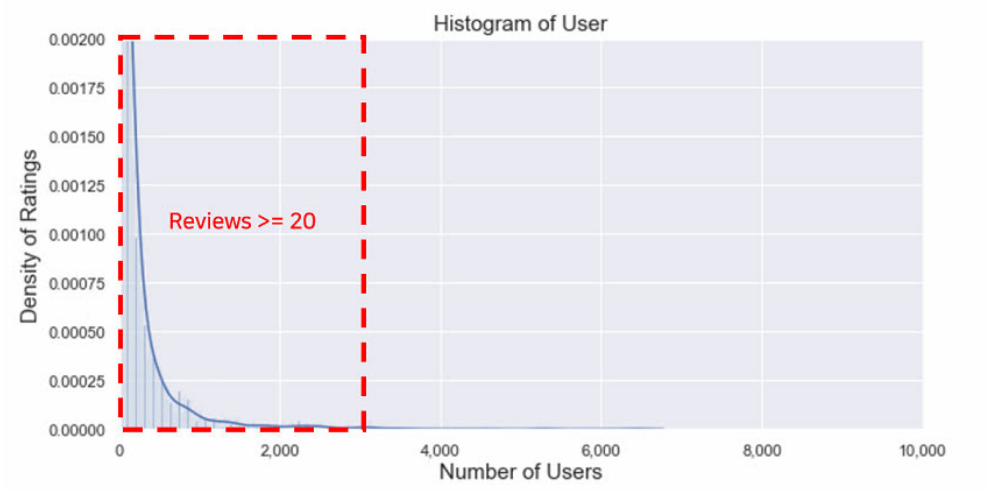
Figure 4. Long-tail graph in user dataset of Rotten